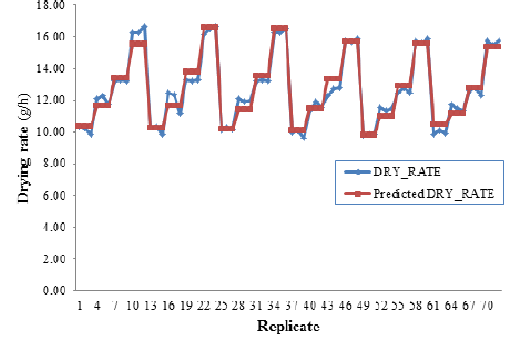
Fig. 2. Comparison of the observed and predicted drying rate of